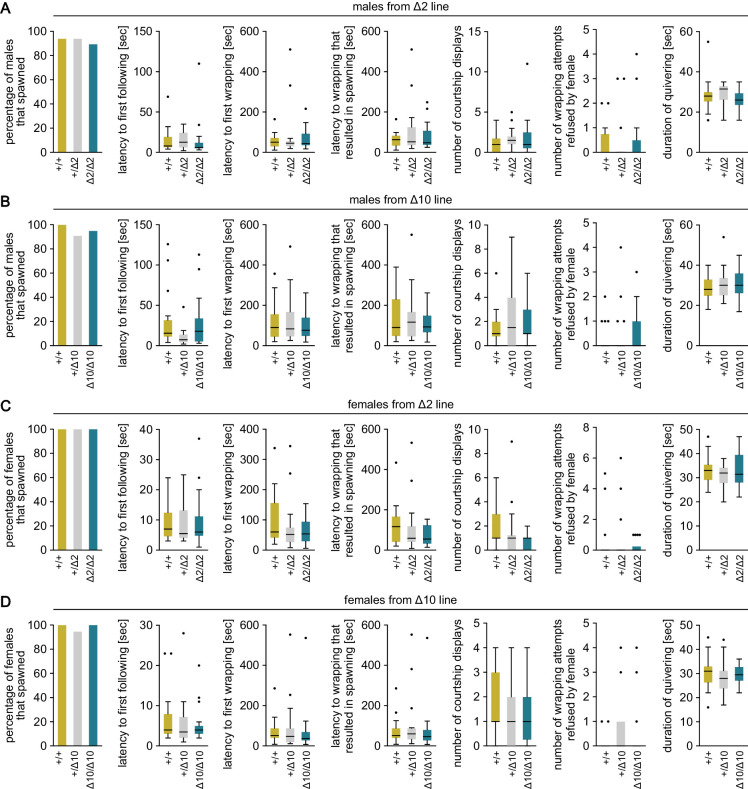
Mating behavior of gal knockout medaka.Various parameters in the mating behavior of males (A, B) and females (C, D) from Δ2 (A, C) and Δ10 (B, D) gal knockout lines. Results were compared among wild-type (+/+), heterozygous (+/Δ2 and +/Δ10), and homozygous (Δ2/Δ2 and Δ10/Δ10) genotypes. n = 17–22 per group.